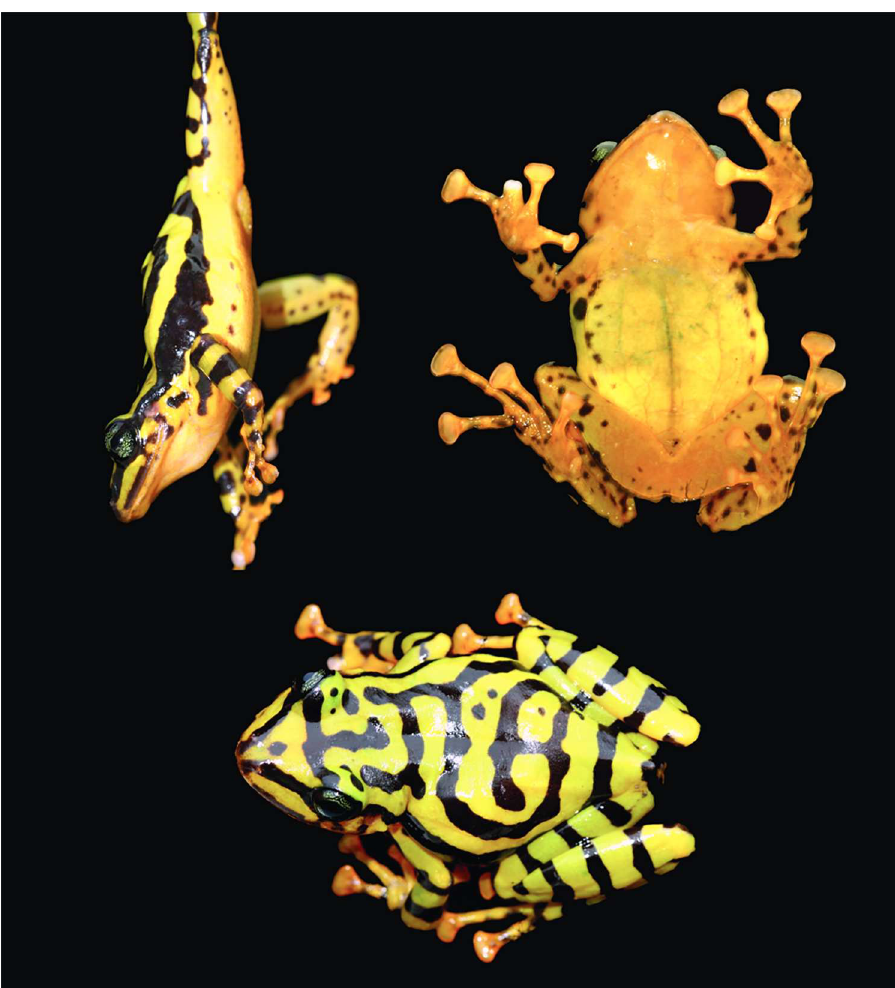
Fig 7. Holotype of Pristimantis ecuadorensis sp. nov., CJ 4084, adult